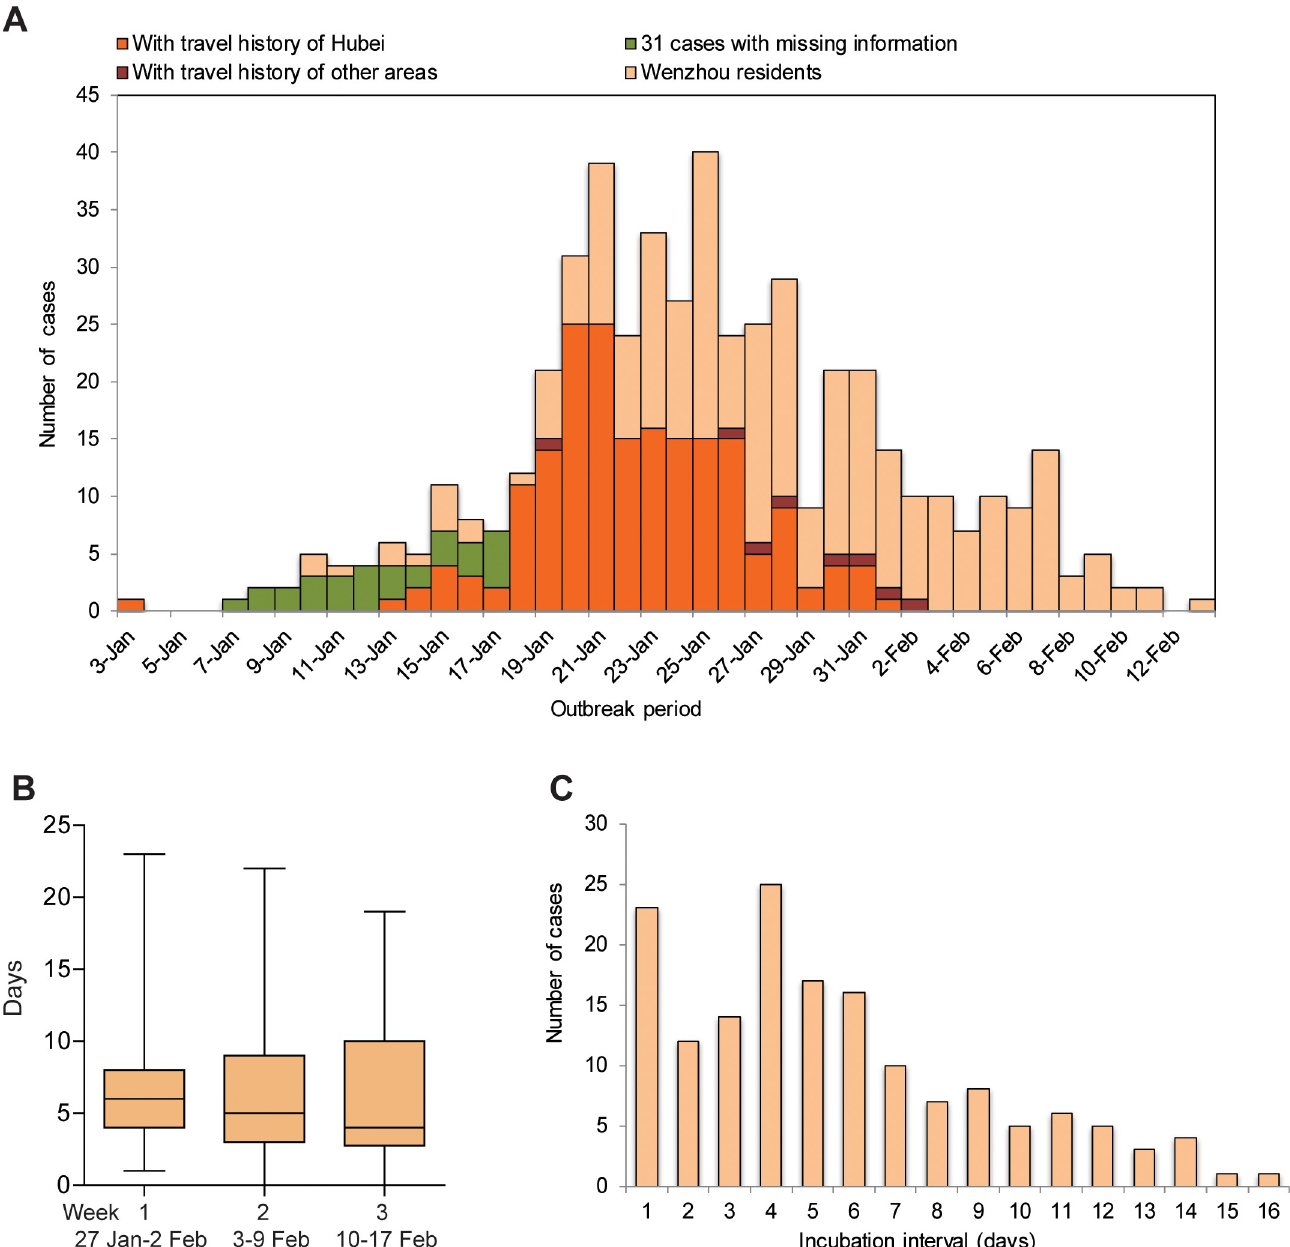
Fig 2. Epidemical features of COVID-19 in Wenzhou. (A) Distribution of disease onset of all the identified cases. Because specific information of the early 31 imported cases is not available; we assumed that date of onset of all imported cases follows a Gaussian distribution, and arbitrarily ranged them in the period from January 7 to 17. (B) Information on duration from onset to hospital admission of 467 cases from January 27 to February 17. (C) Distribution of interval of incubation of 157 imported